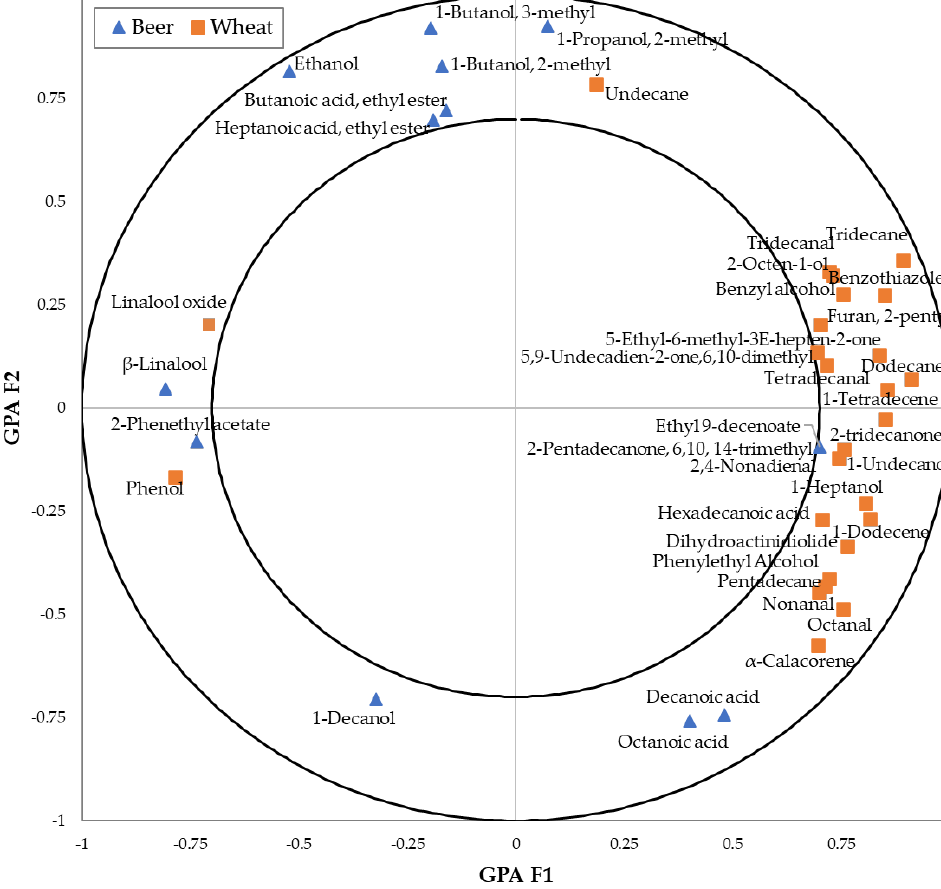
Figure 3. GPA correlations between dimensions in the initial consensus configuration and the first two factors by using GC-MS datasets.